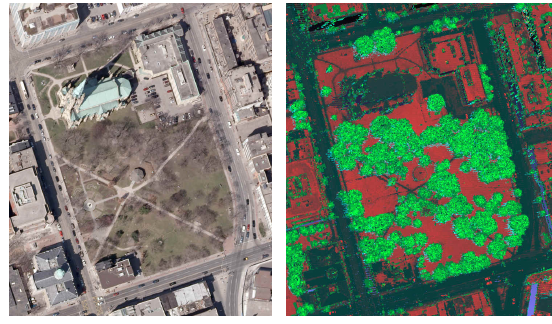
Figure 6. Missing and erroneous data in the provided reference data of the Toronto dataset 1 .